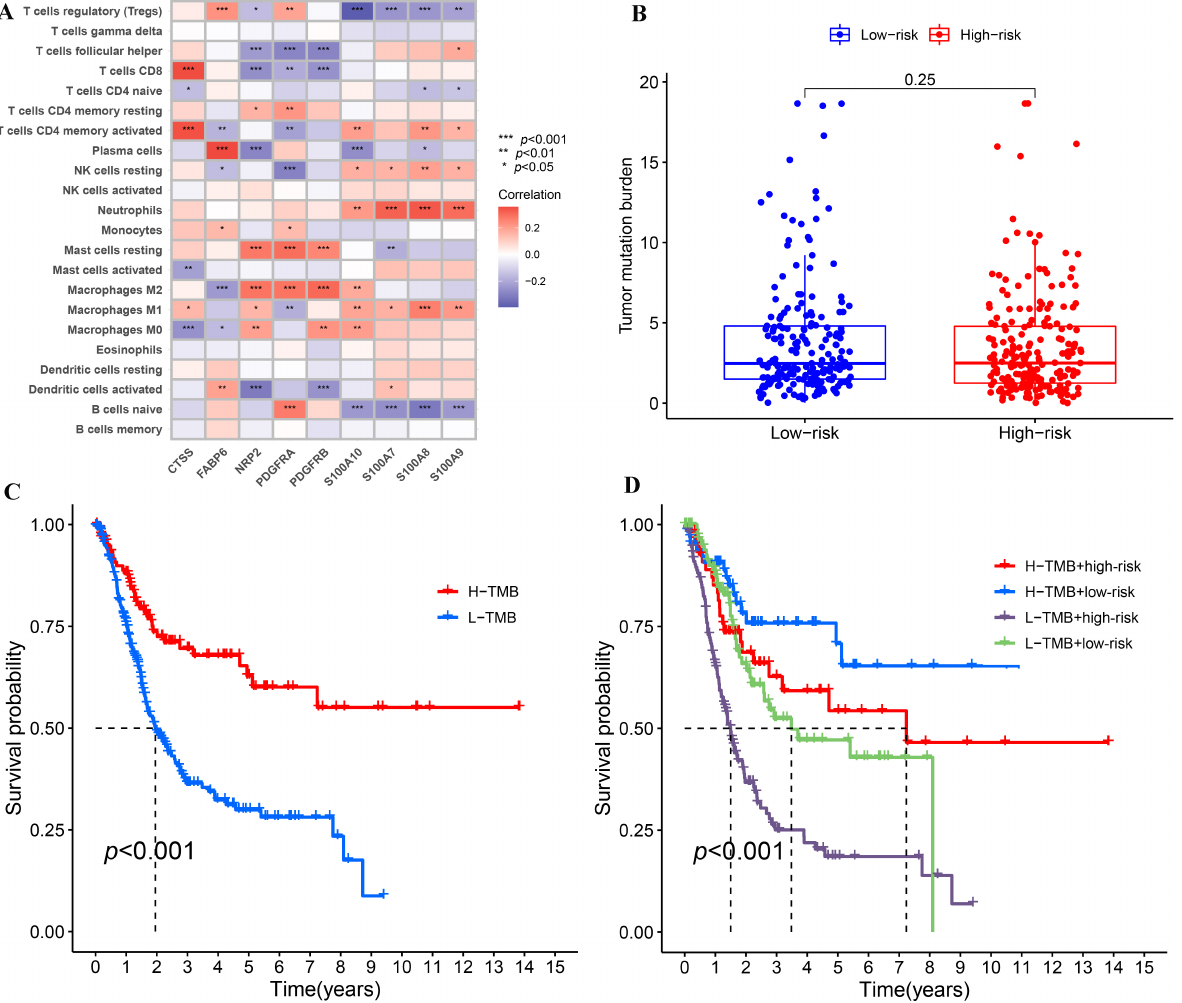
Figure 6. The correlations of IRPM-based risk characteristic with immune-cell infiltration and TMB. ( A ) Heatmap showed the correlations between 9 genes used to construct IRPM and 22 kinds of human immune cells. ( B ) Comparison of TMB between high-risk and low-risk groups in the TCGA- BLCA cohort. ( C ) Survival analysis based on the TMB in the TCGA-BLCA cohort. ( D ) Survival analysis for four groups stratified by combining the TMB and the IRPM-based risk characteristic in the TCGA-BLCA